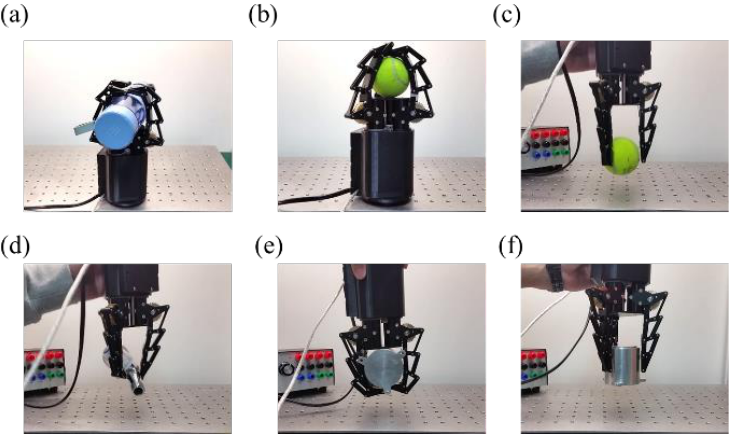
Figure 17. Photos showing spatial adaptivity of the gripper in grasping ( a ) a cylindrical bottle, ( b ) a tennis ball, and ( c – f ) hardware with irregular shapes.